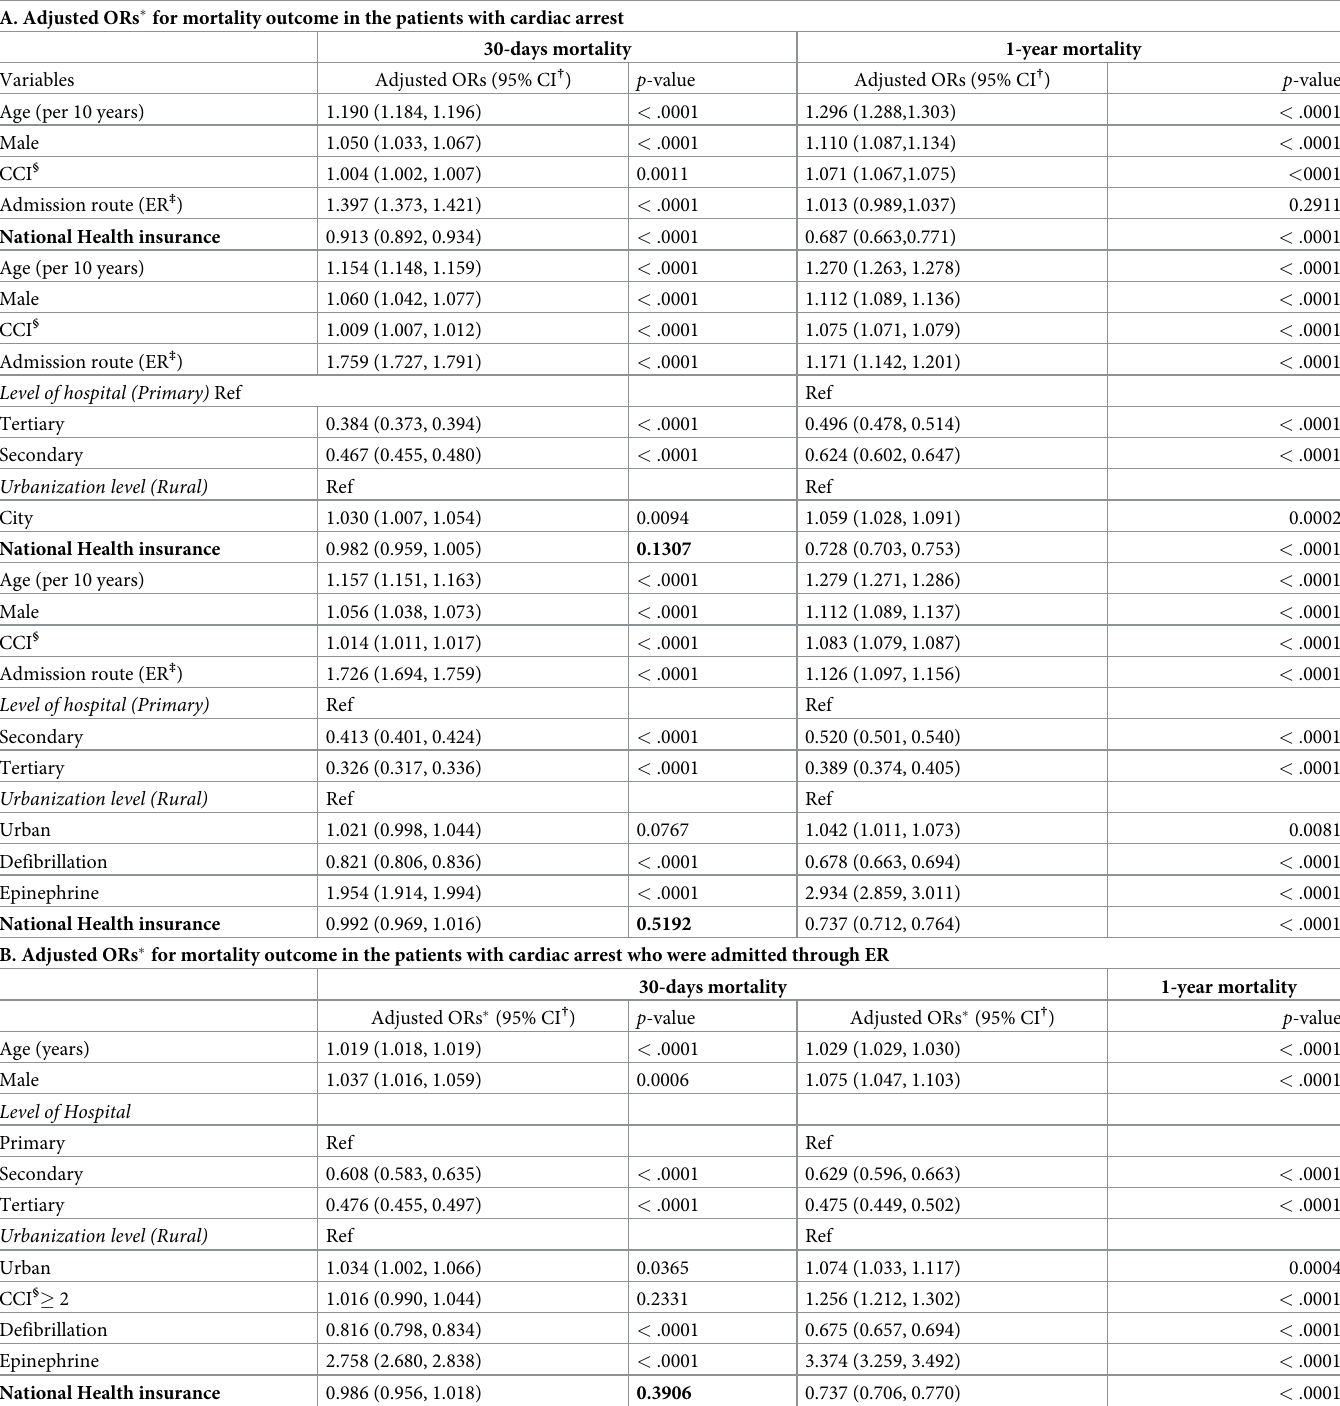
Table 4. Factors independently associated with short-term and long-term mortality